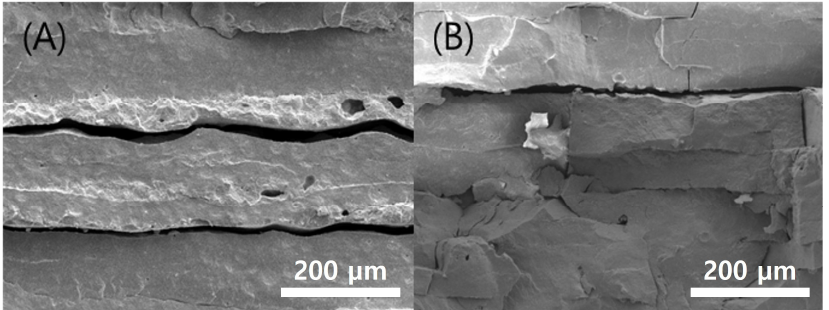
Figure 11. Cross-sectional SEM images Sintered specimens according to various chamber temps: ( A ) 40 °C; ( B ) 60 °C.